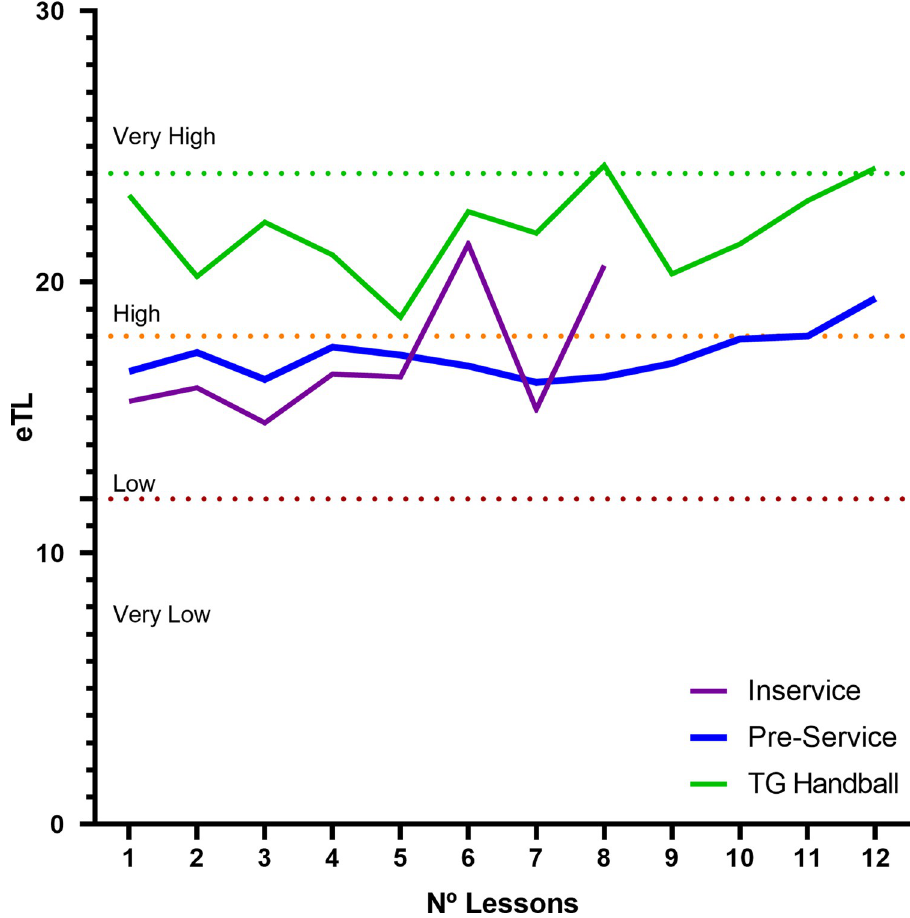
Fig 2. eTL per session for the types of teachers. The in-service teachers planned � 8 Lessons.